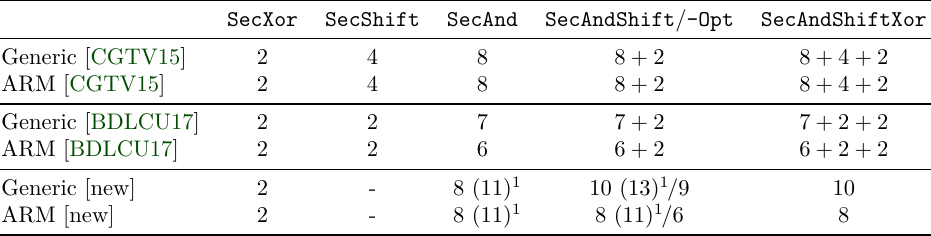
Table 1: Comparison of masked operations.